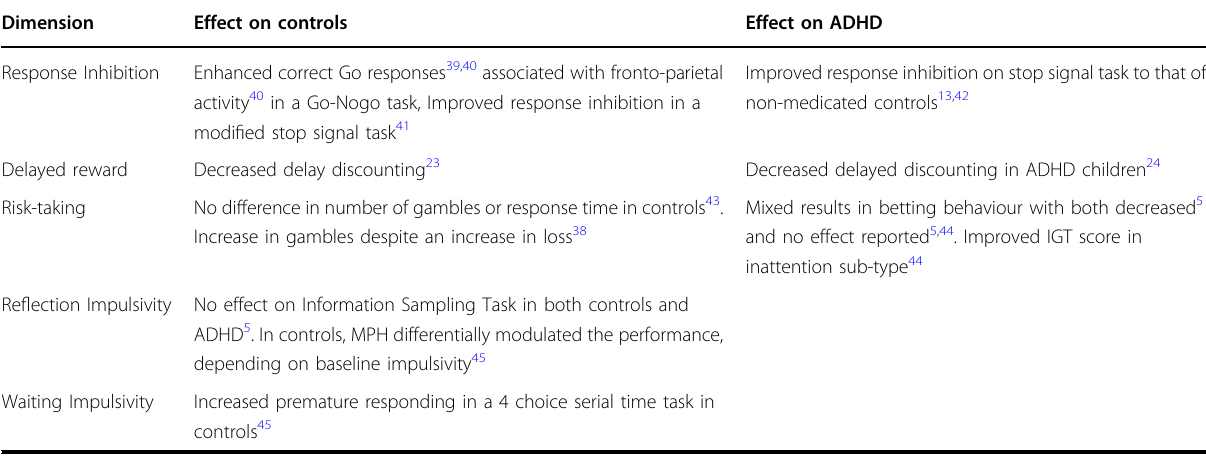
Table 1 Effect of methylphenidate on impulsivity subtypes in healthy controls and attention-de fi cit hyperactivity